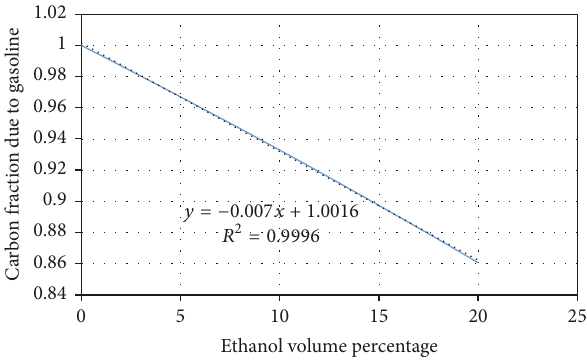
Figure 9: Carbon fraction (atom or mass) contribution by gasoline in gasoline: ethanol blend. 𝑥 -axis: ethanol volume percentage; 𝑦 - axis: carbon atom fraction contributed by gasoline in blend. The curve is almost linear for small ethanol volume fraction. Gasoline is assumed to be CH 2.25 . RQ from exhaust analysis needs to be multiplied by C fraction from gasoline to estimate CO 2 contribution by